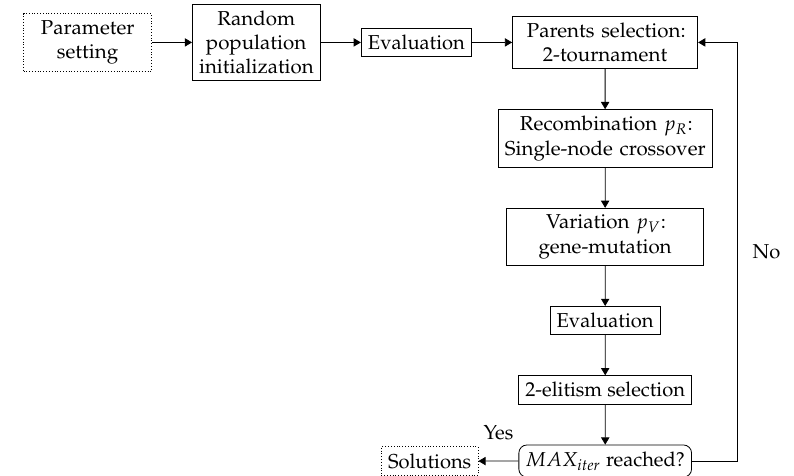
Figure 1. Breeding pipeline of Evolutionary Matrix Factorization (EMF)